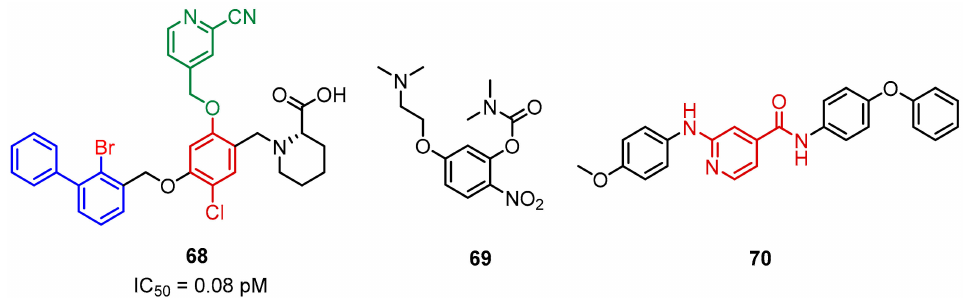
Figure 29. Examples of the benzyl phenyl ether derivatives 68 reported by Feng et al., [82]; the resorcinol ( 69 ) and isonicotinic acid ( 70 ) derivatives reported, respectively, by Li et al. [83] and Sun et al.